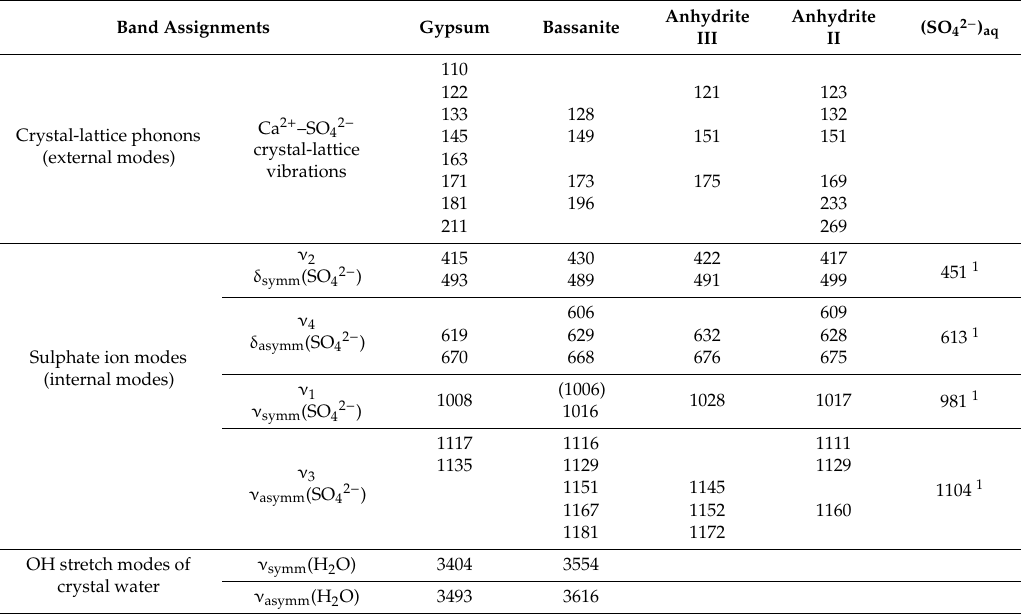
Anhydrite Anhydrite (SO 42 − ) aq III II